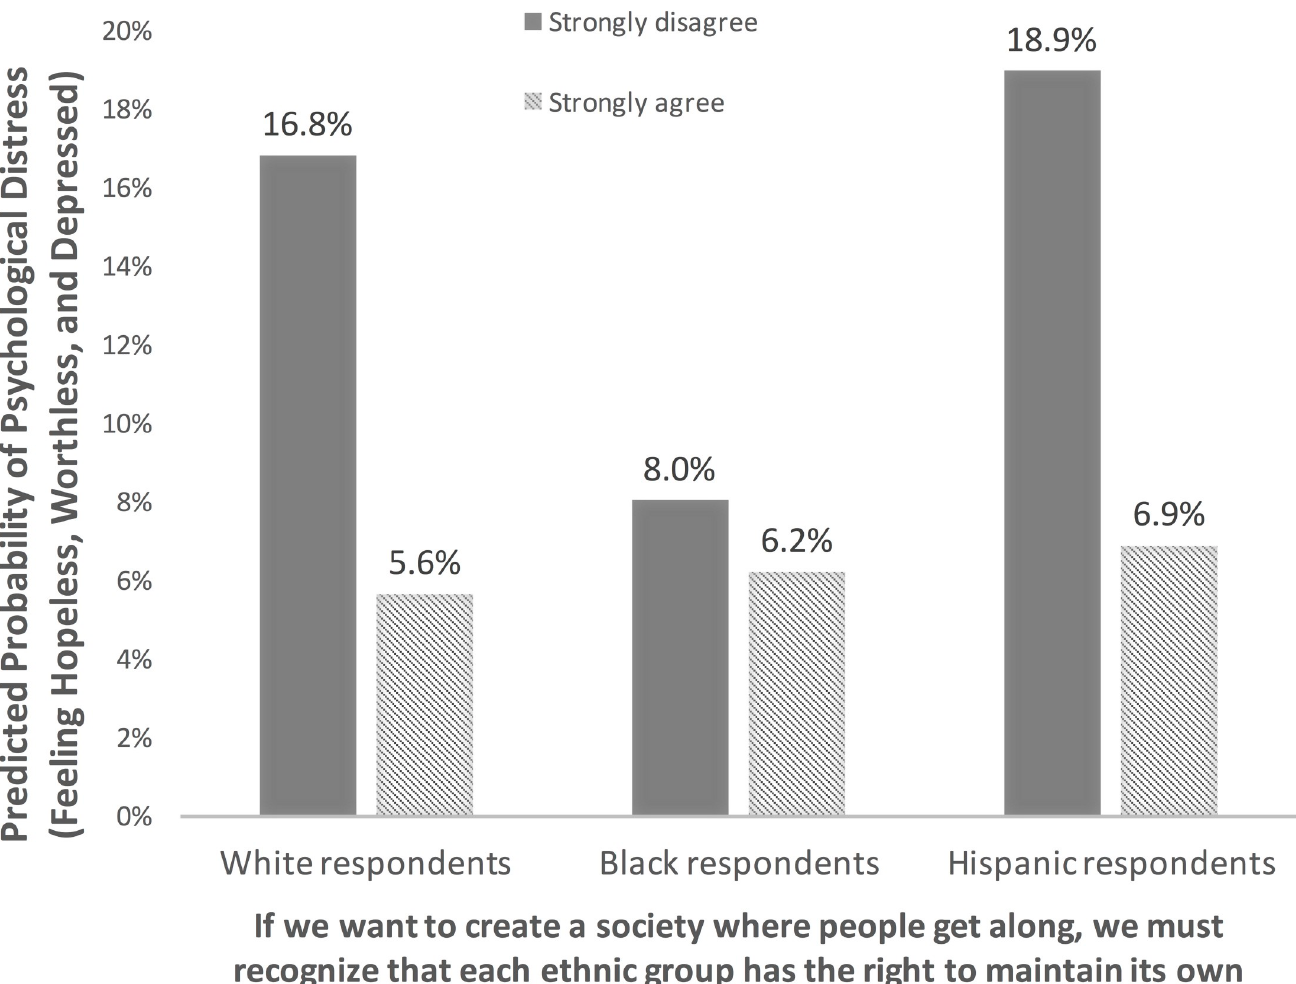
Fig 1. Predicted probability of psychological distress by multiculturalism